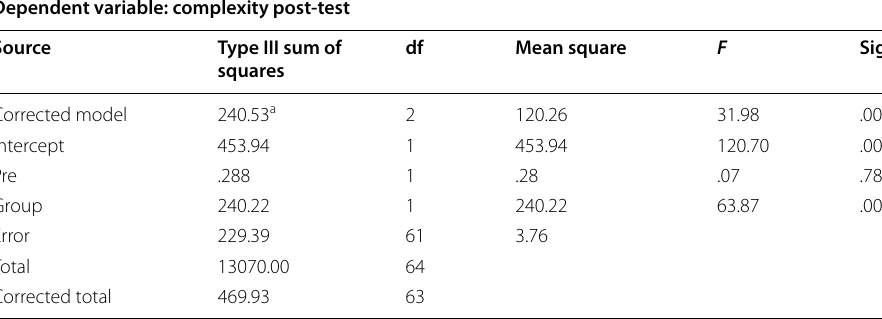
Table 6 Writing complexity inferential statistics